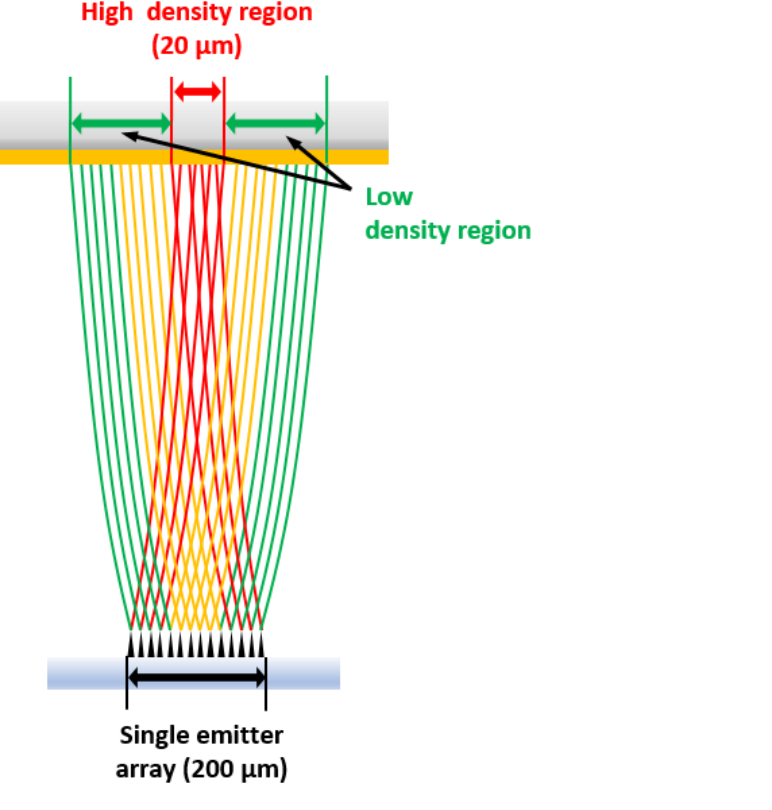
Figure 10. Electron beam trajectories using diode configuration of VACNTs and classification of dose regions for effective patterning of OTS.